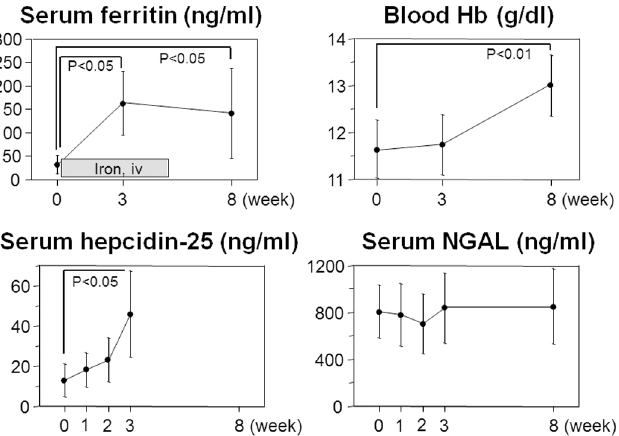
Fig 3. Effects of iron administration upon clinical parameters in maintenance HD patients. Mean ± SD. Comparison between different time points was carried out by repeated-measures ANOVA with Dunnett post test. N =